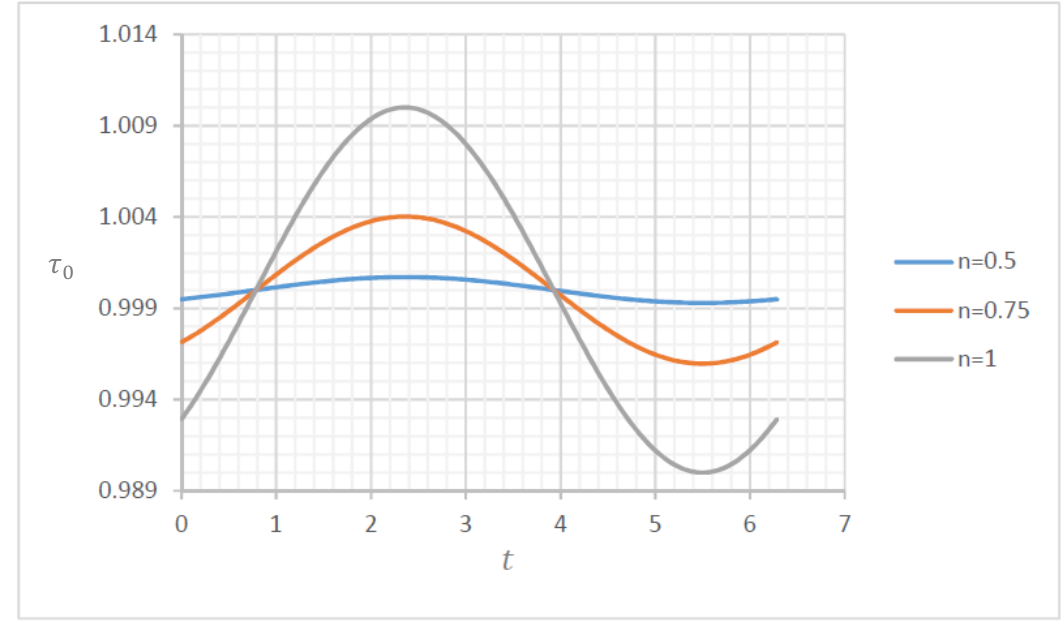
Figure 5. Wall shear stress for Ω = 1, Re = 100, ε = Figure 5. Wall shear stress for  = 1 , 𝑅𝑒 = 100 , 𝜀 = 0.1 . Figure 5. Wall shear stress for  = 1 , 𝑅𝑒 = 100 , 𝜀 = 0.1 .